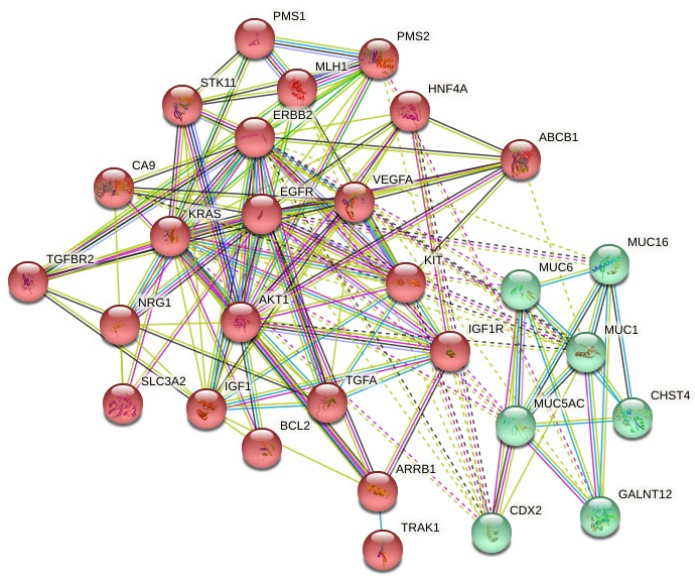
Figure 6. Genetic network analysis of ASCs.